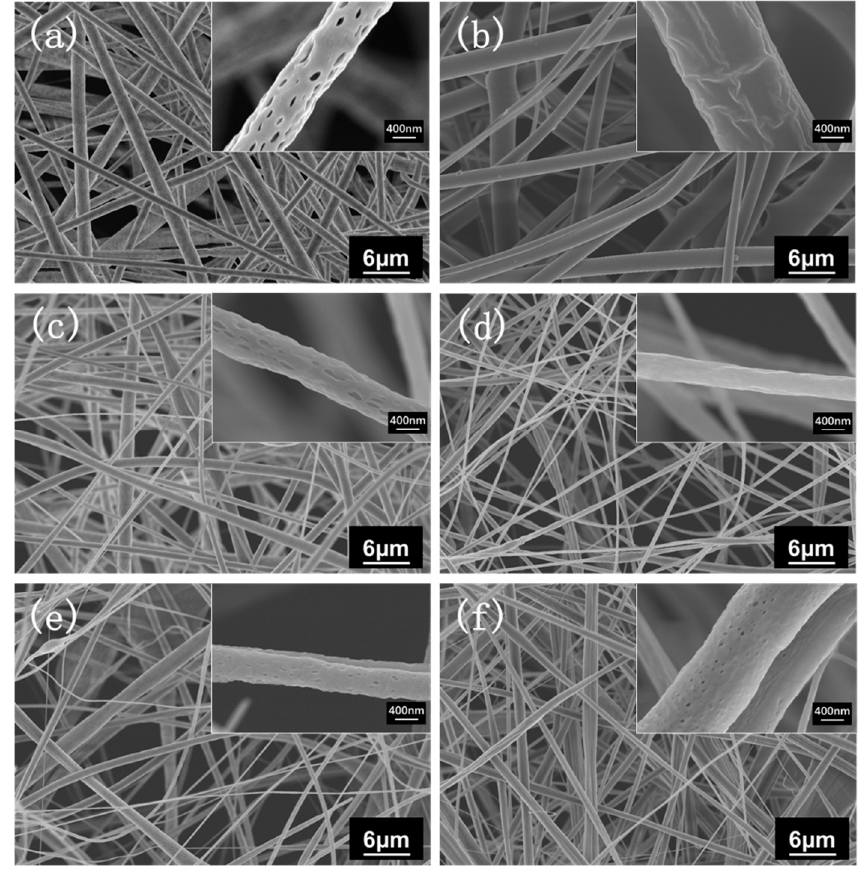
Figure 4. SEM micrographs of di ff erent fi ber membranes: ( a ) PLA, ( b ) CDA, ( c ) PLA/CDA (9/1), ( d ) PLA/CDA (8/2), ( e ) PLA/CDA (7/3), ( f ) PLA/CDA (6/4).